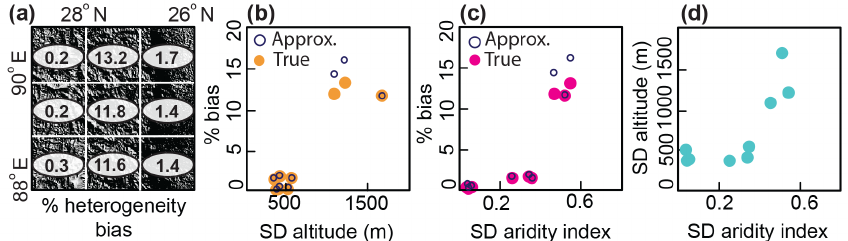
Figure 5. Heterogeneity bias in average ET for the nine grid cells of the terrain shown in Fig. 4a (88–91 ◦ E, 26–29 ◦ N) calculated from high- resolution (1km) spatial variation of mean annual P and PET in each grid cell (Eq. 7). “True” heterogeneity bias is estimated by averaging the ET predicted by the Budyko curve for each 1km pixel, and comparing this average with the ET predicted from the same curve using the average P and PET in the corresponding grid cell. “Approximate” heterogeneity bias is estimated from Eq. (8). The % bias is highest in cells with large standard deviation in altitude and aridity